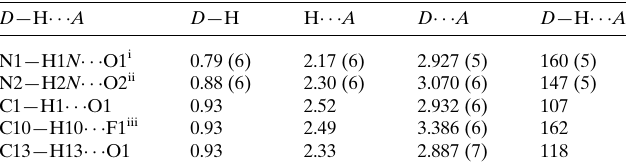
Table 1 Hydrogen-bond geometry (A˚ , (cid:2)